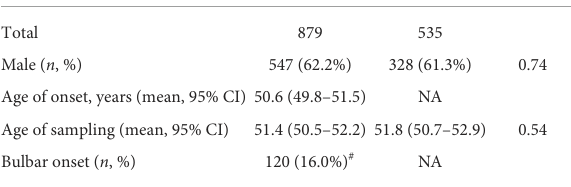
TABLE 1 Demographic features of patients ALS and